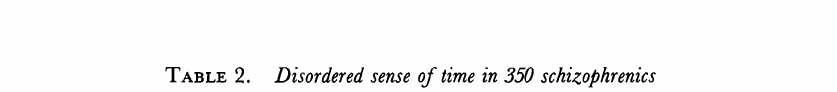
TABLE 2. Disordered sense of time in 350